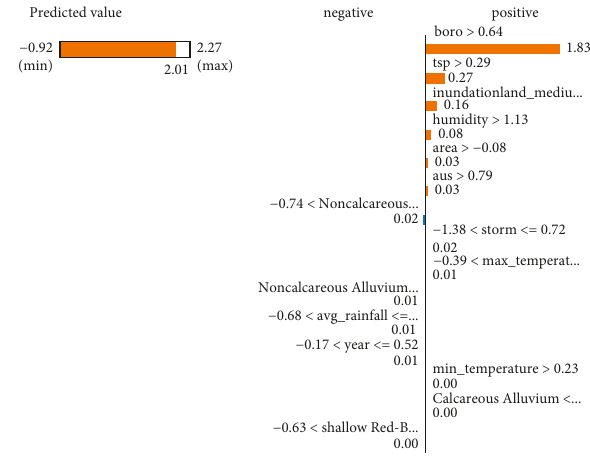
Figure 20: A plot of LIME model values for the XGBoost model and Aman yield